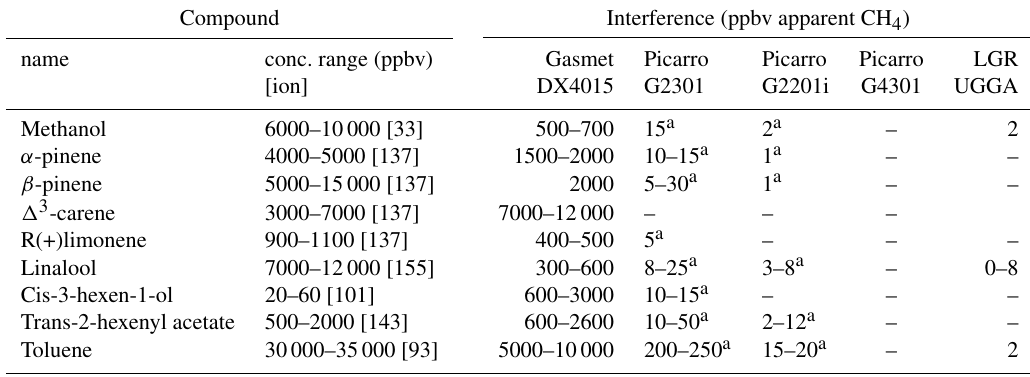
Table 2. Summary of interferences detected in qualitative tests.